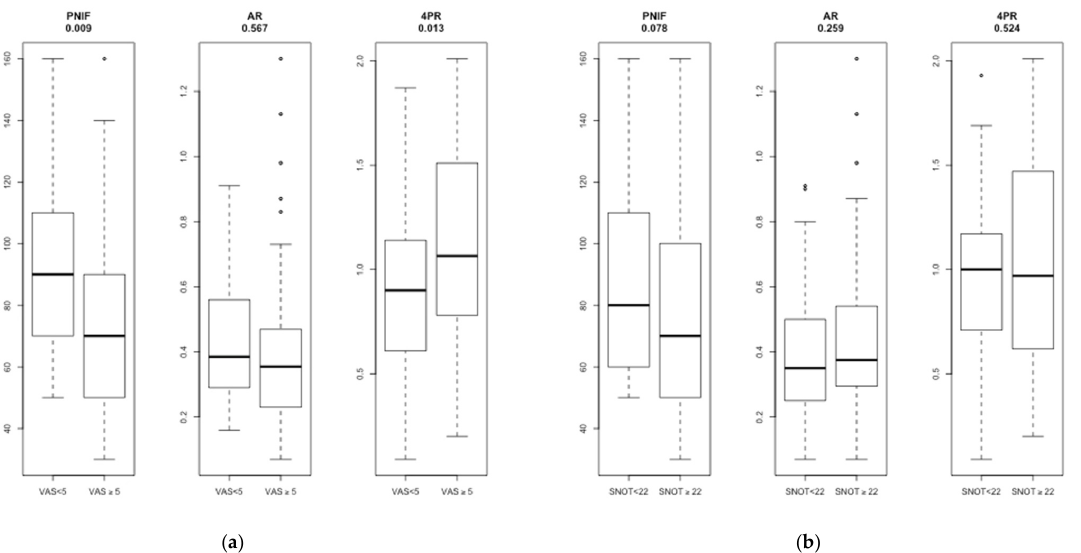
Figure 4. Box-plot of PNIF, AR and 4PR compared with VAS-NO ( a ) and SNOT-22 ( b ). PNIF: Peak Nasal Inspiratory Flow; AR: acoustic rhinometry; 4PR: 4-Phase Rhinomanometry. Nasal Inspiratory Flow; AR: acoustic rhinometry; 4PR: 4-Phase